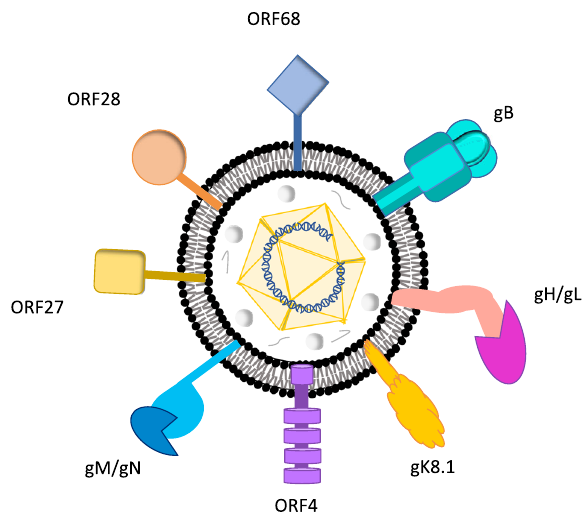
Fig. 3 Schematic diagram of major Kaposi sarcoma herpesvirus membrane structural glycoproteins. Individual viral components are indicated. The viral genome is a linear double-stranded DNA enclosed in an icosahedral capsid. This nucleocapsid is surrounded by the tegument. The tegument is a dense amorphous proteinac- eous structure. The viral envelope is a lipid bilayer membrane of host origin that contains ten different KSHV glycoproteins. Conserved glycoproteins that are potential preventive vaccine antigens include gB, gH, gL, gM, and gN, and accessory glycopro- teins gK8.1, ORF4, ORF27, ORF28, and ORF68.